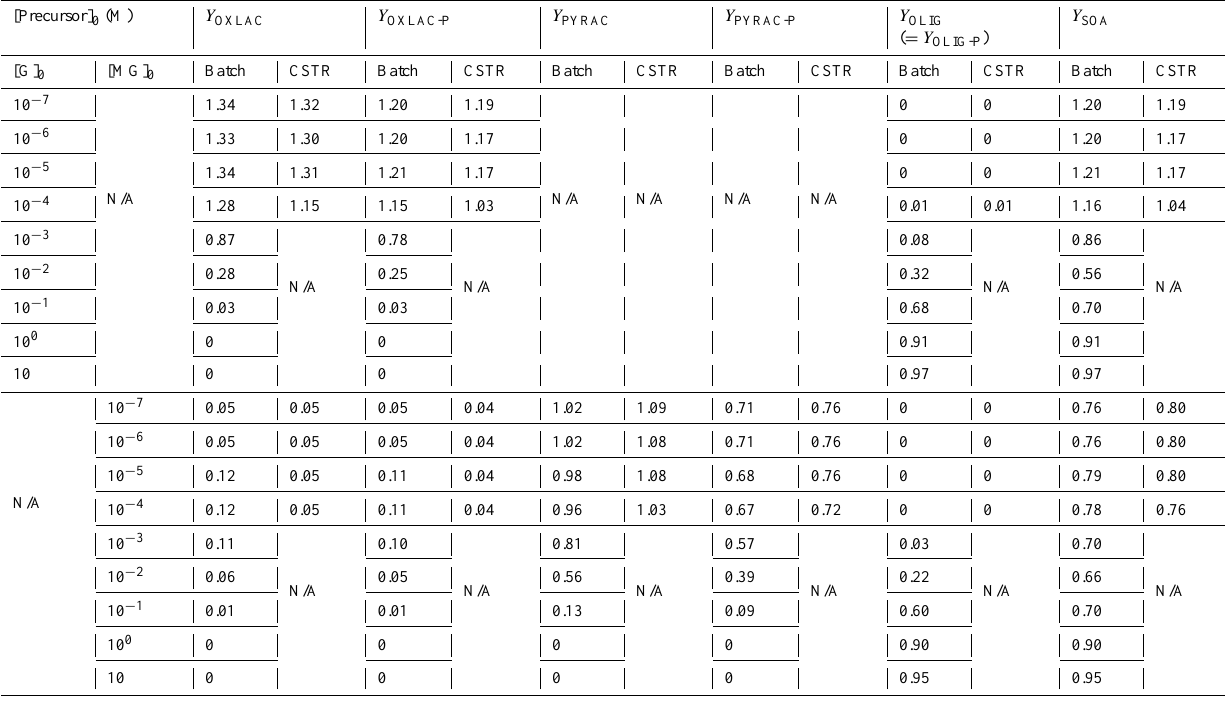
Table 1. Product yields, particle-phase product yields and SOA